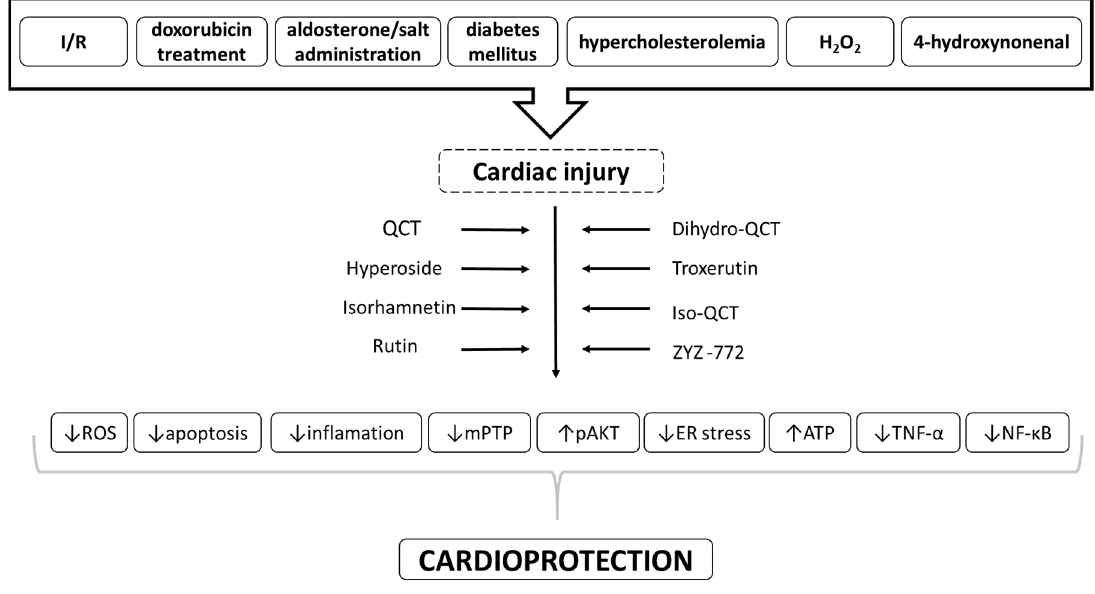
Figure 3. Scheme of potential cardioprotective effects of QCT and its derivatives in heart injury outlining the proposed molecular mechanisms involved in their action.